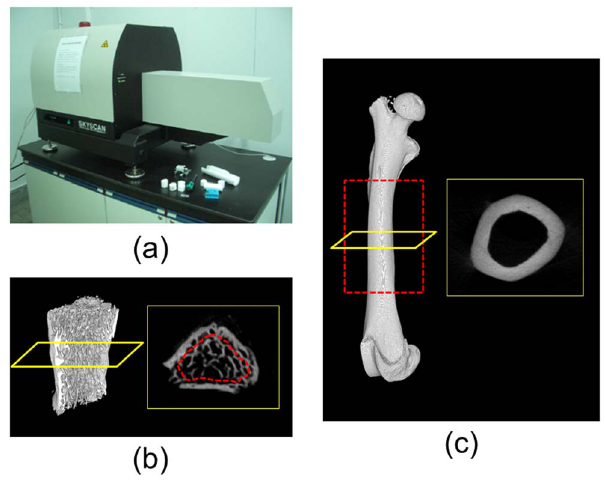
Figure 1. Micro-CT machine, images and 3D renderings. (a) Micro-CT machine (Skyscan 1076), (b) hemi 5th lumbar vertebral body (excluded the posterior element) in left, the section of the micro-CT image in right (the region of interest for trabecular bone calculated also shown in dotted red line), and (c) intact femur (the region of interest for cortical bone calculated also shown in dotted red line) in left, the section of the micro-CT image in right.